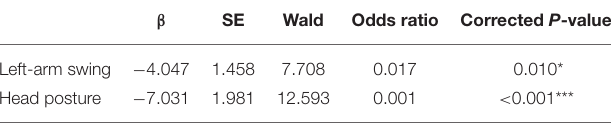
TABLE 5 | Binary logistic regression model of frequency-domain principal components.